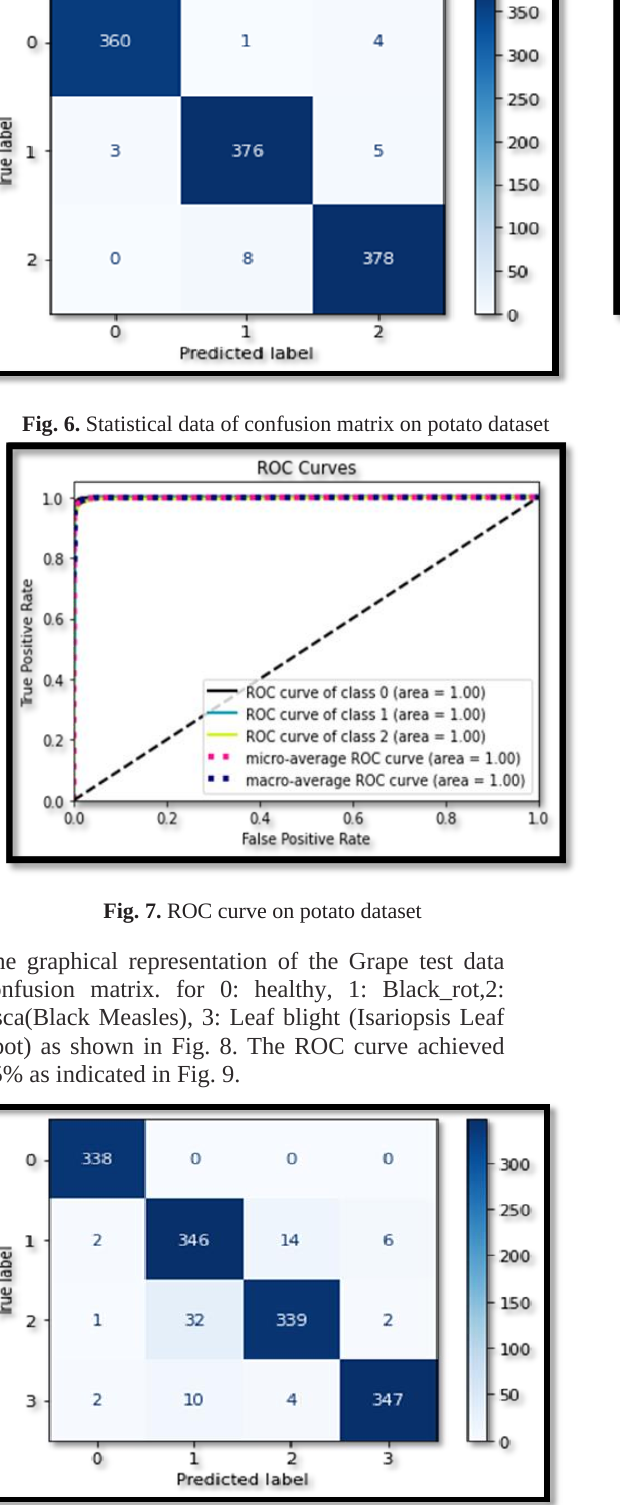
Fig. 8 . Statistical data of confusion matrix on grapes dataset